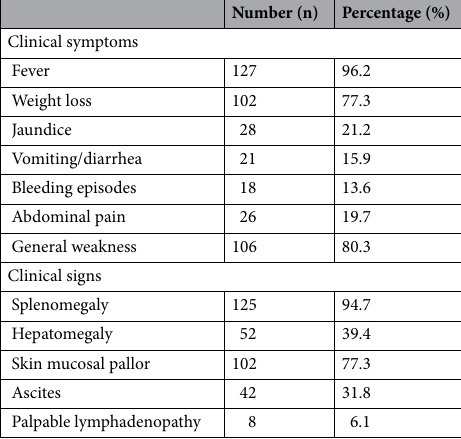
Table 2. The frequency of clinical features of VL patients at Tefera Hailu Memorial Hospital, Sekota, Northeast Ethiopia from January 2017 to December 2021.